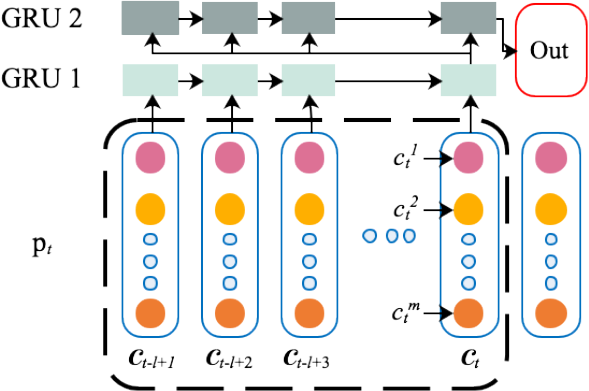
Figure 5. Architecture of the proposed